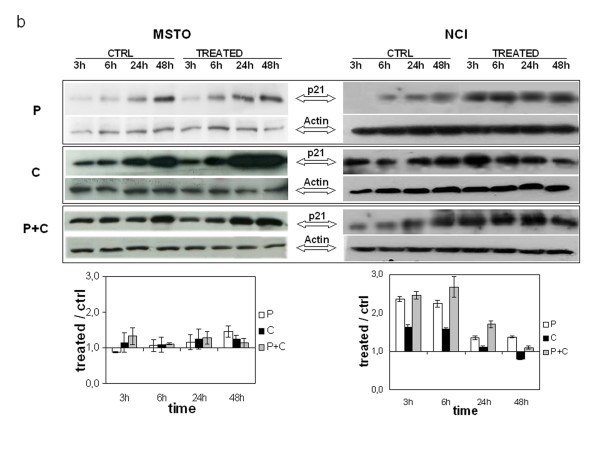
Effects of piroxicam alone and in combination with CDDP on cell cycle regulatory proteins. p21 was analysed by western blotting in MSTO (left side) and NCI (right side) treated with piroxicam and/or CDDP for different times. Electrophoretic bands were analyzed using Scion Image program. Experiments were repeated in triplicate and media values and standard deviations were calculated. CTRL = control; P = piroxicam; C = CDDP.